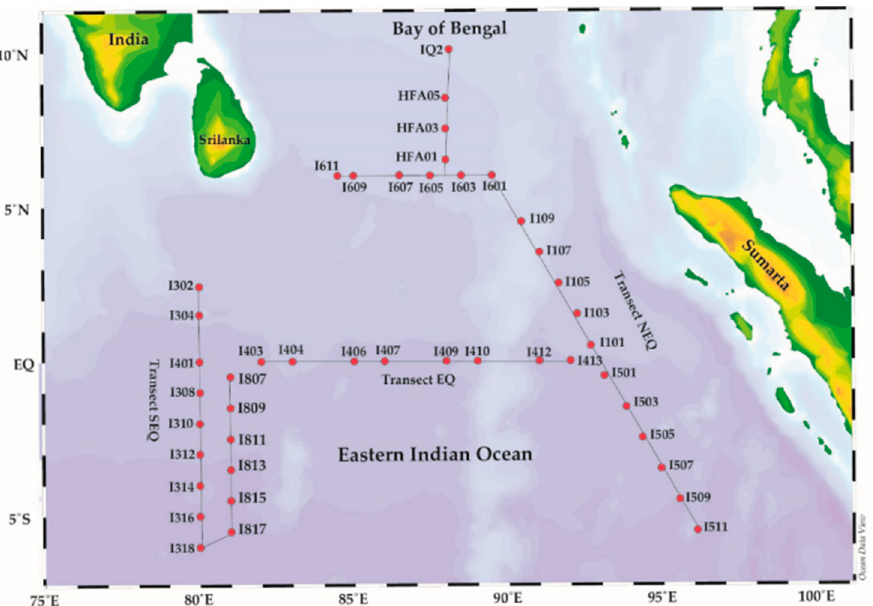
Figure 1. Sampling stations of the eastern Indian Ocean (EIO) during the spring period, 2014. The red dots indicate sampling stations between the three regional zones: North-equatorial zone (NEQ) at longitude 90 ◦ E, the equatorial zone (EQ) at Lati-0, and the south-equatorial zone (SEQ) at longitude 80 ◦ E.